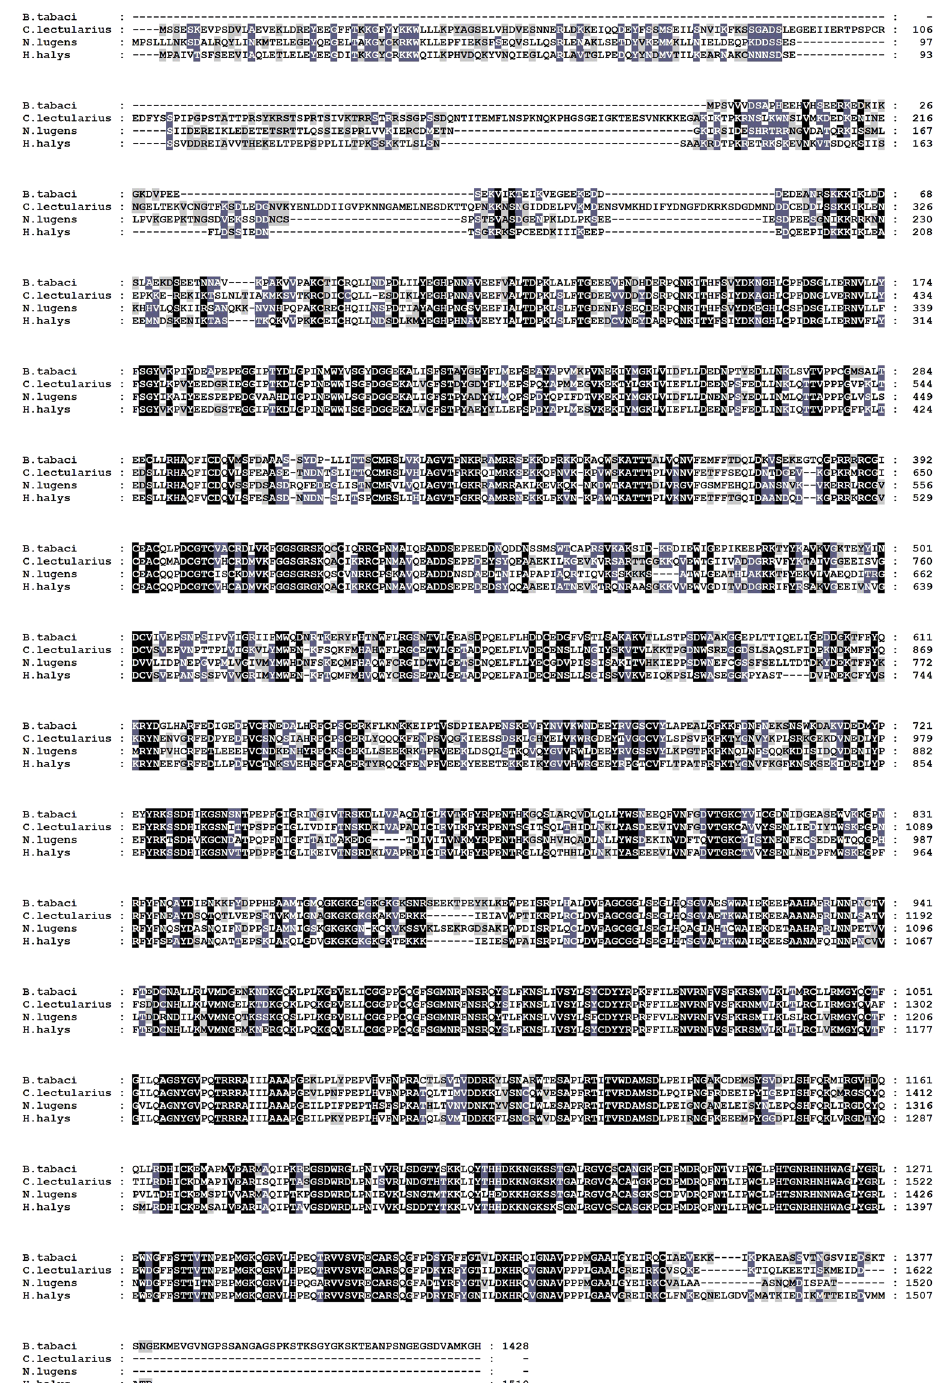
Figure 3. Multiple alignment of Dnmt1 proteins from B. tabaci MED and its homologues in the Hemiptera species. The deduced amino acid sequence of BtDnmt1 is highly conserved at catalytic domain when compared with previously identified Dnmt1 amino acid sequences, including C. lectularius (XP_014253428), H. halys (XP_014281484) and N. lugens